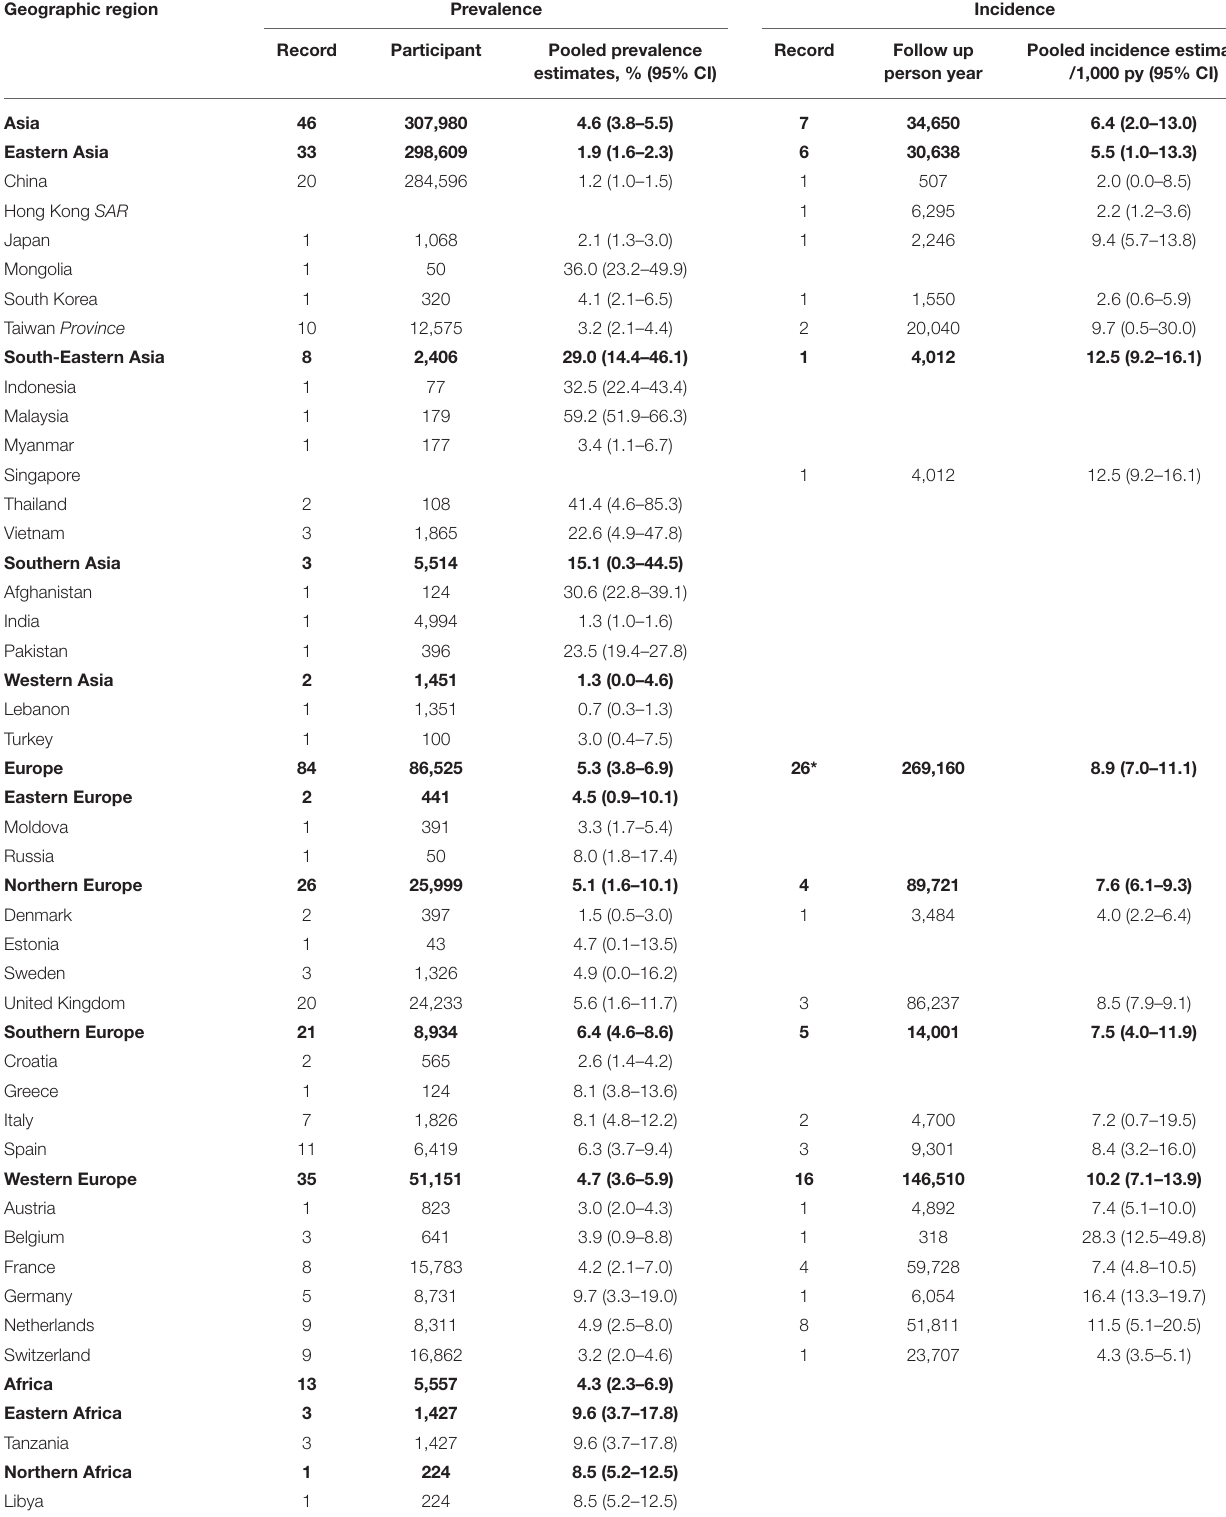
TABLE 1 | Estimates of anti-HCV prevalence and incidence by geographic region. Geographic region Prevalence